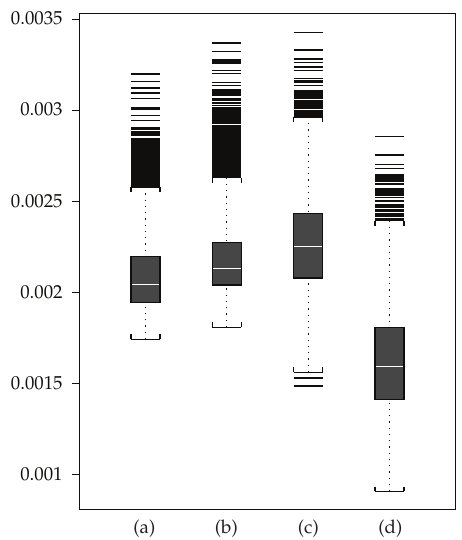
Figure 7: Example 5.2: Boxplots of the 5000 RMSE-values using estimators with the Daubechies D8 wavelet, for linear estimates (cid:5) a (cid:6)